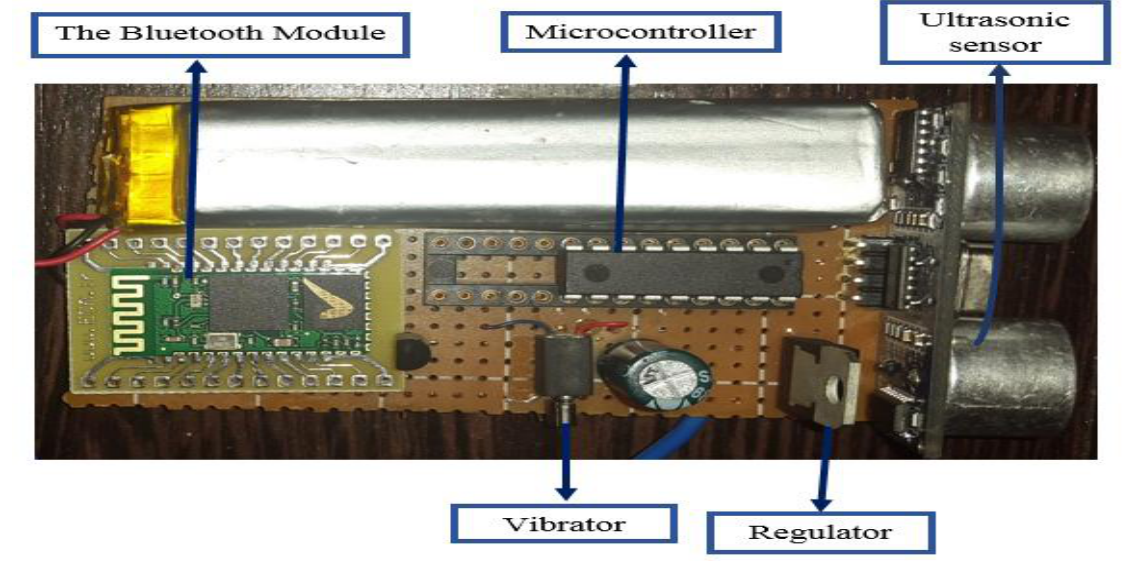
Figure 4. Ultrasonic sensor